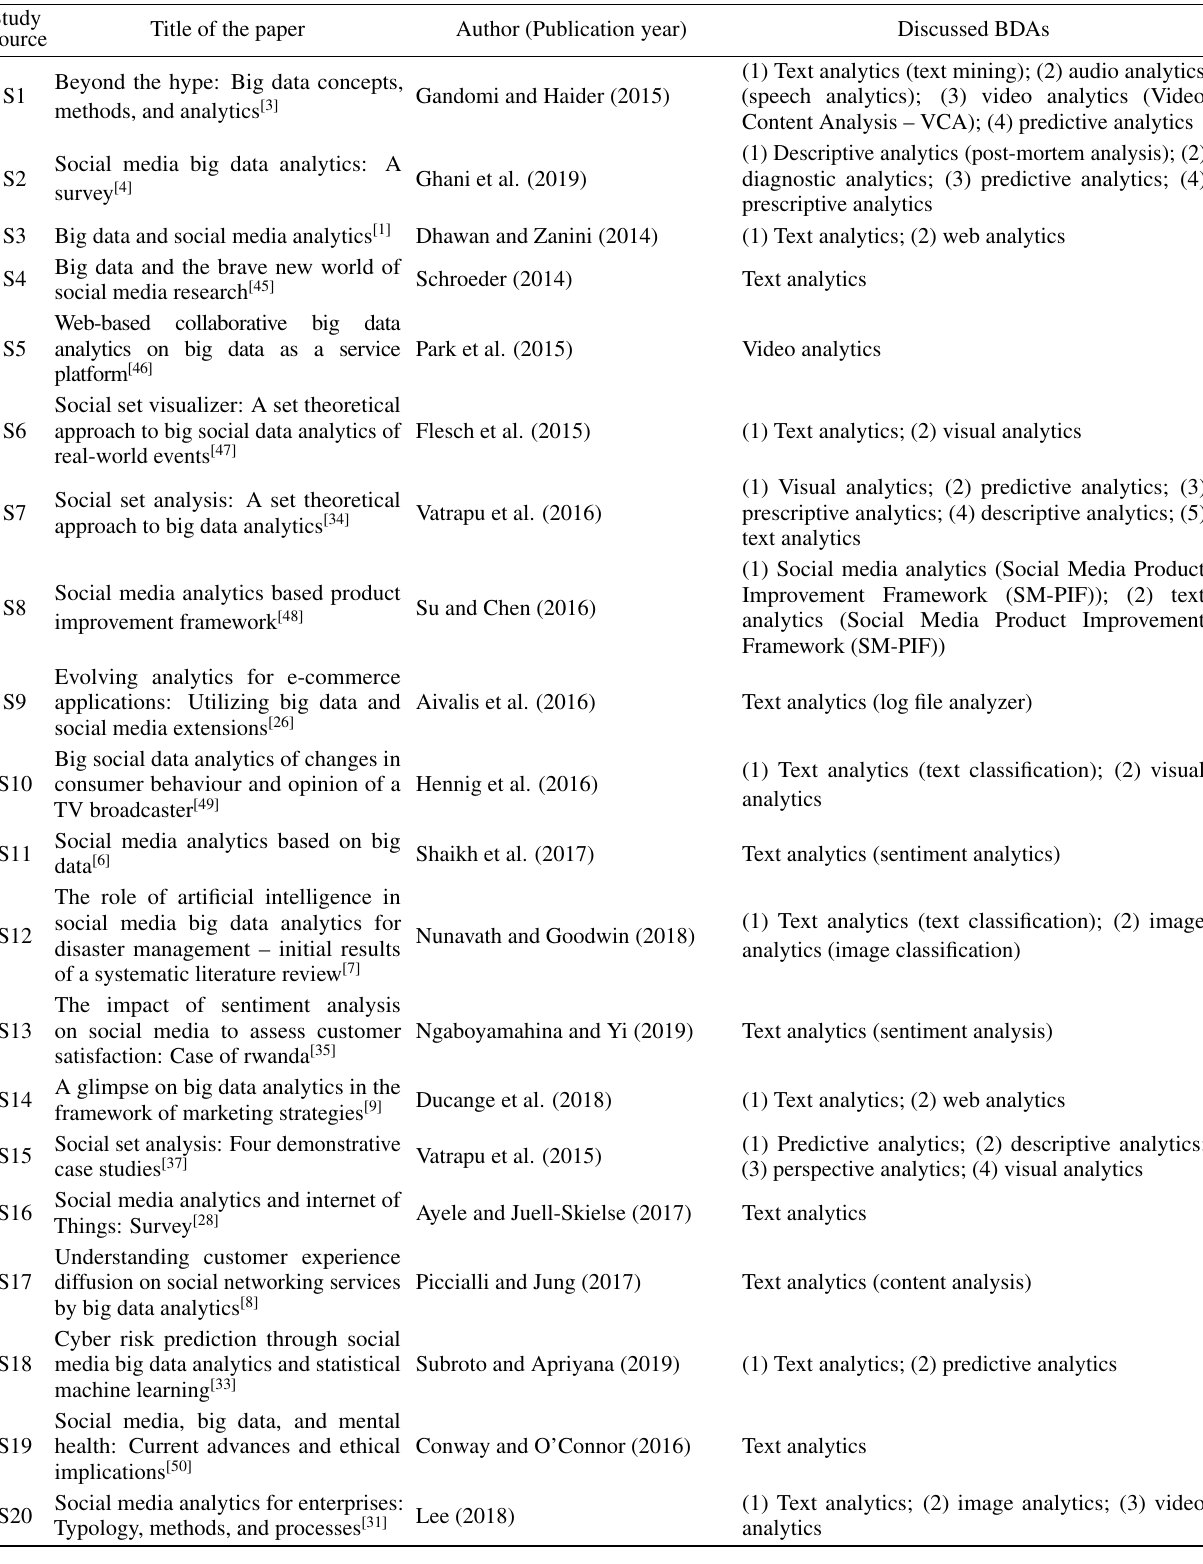
Table 6 Most used social data